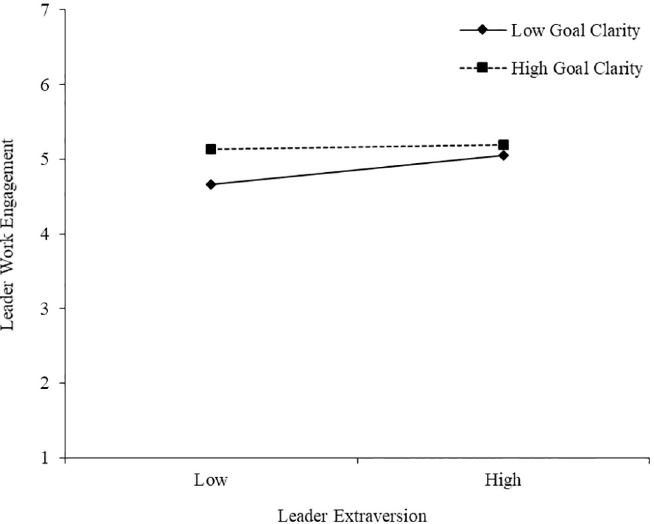
Fig 2. Moderating effect of goal clarity on the relationship between leader extraversion and leader work engagement.